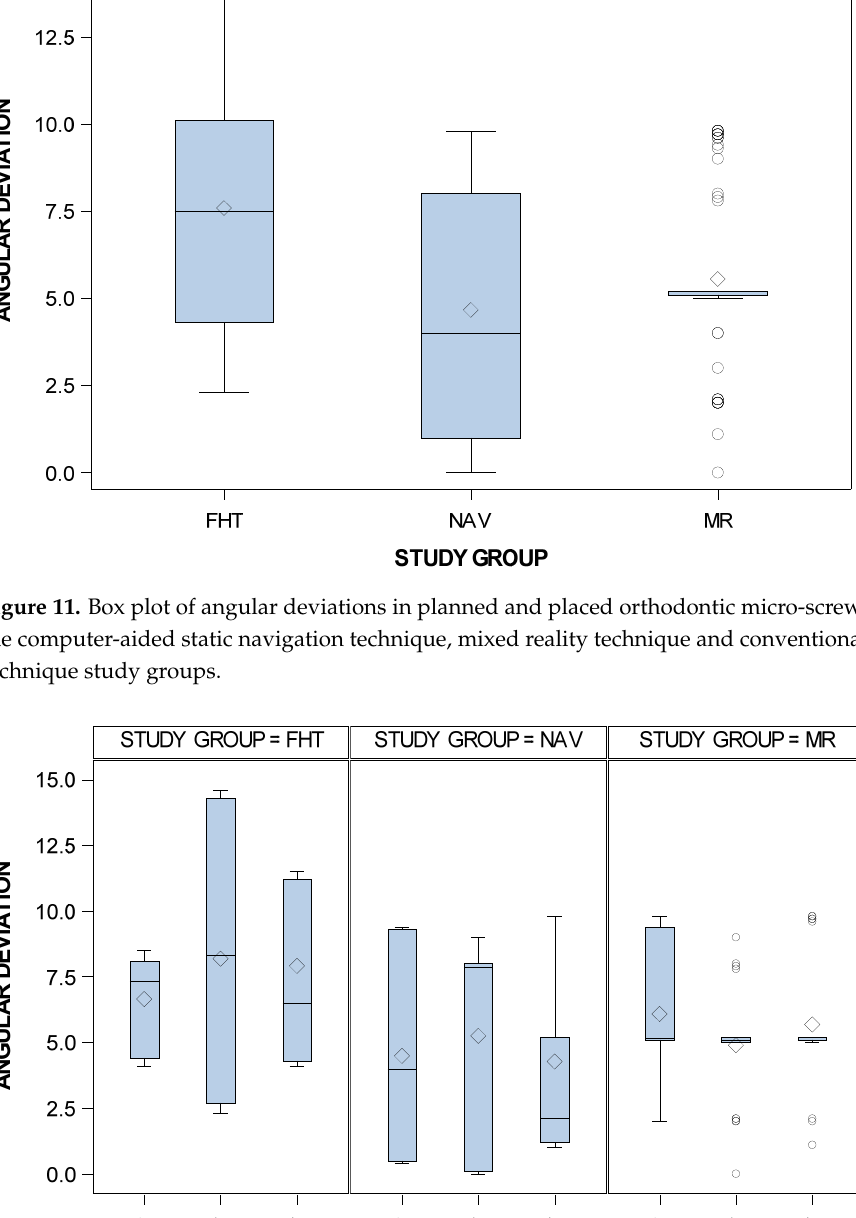
Table 6. Descriptive deviation values at angular level (°) of the orthodontic micro-screws placed by using conventional freehand technique, mixed reality technique and computer-aided static navigation technique study groups in the incisive- canine, premolar and molar dental sector.